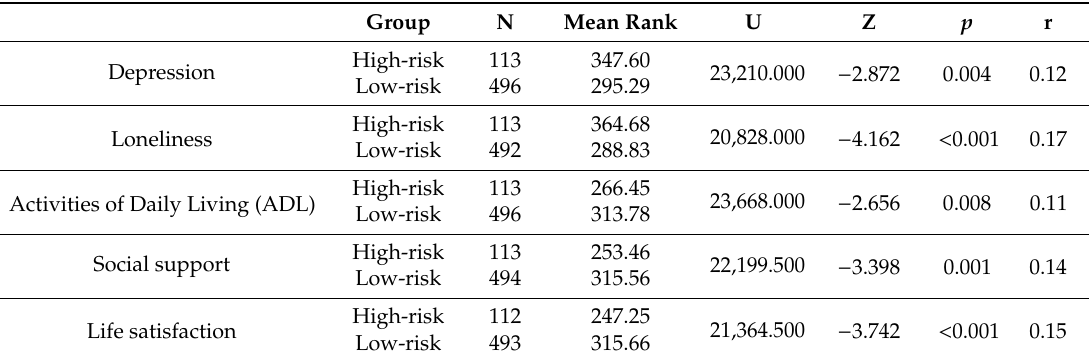
Table 3. Univariate analyses in both group (N =